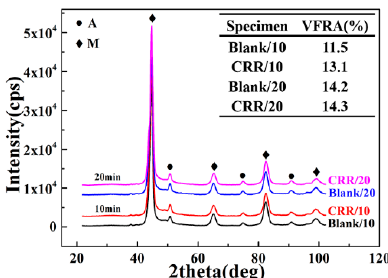
Figure 4. X-ray diffraction (XRD) patterns of specimens after QT with and without CRR under different austenitizing times.